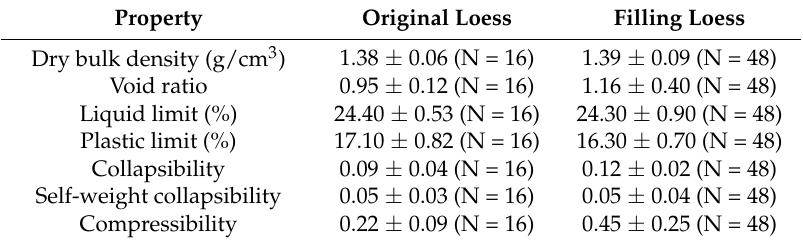
Table 2. Main physical-mechanical properties of soil test samples. N denotes the number of samples on which measurements were made in each experiment or soil test, and ± values indicate the SD from the